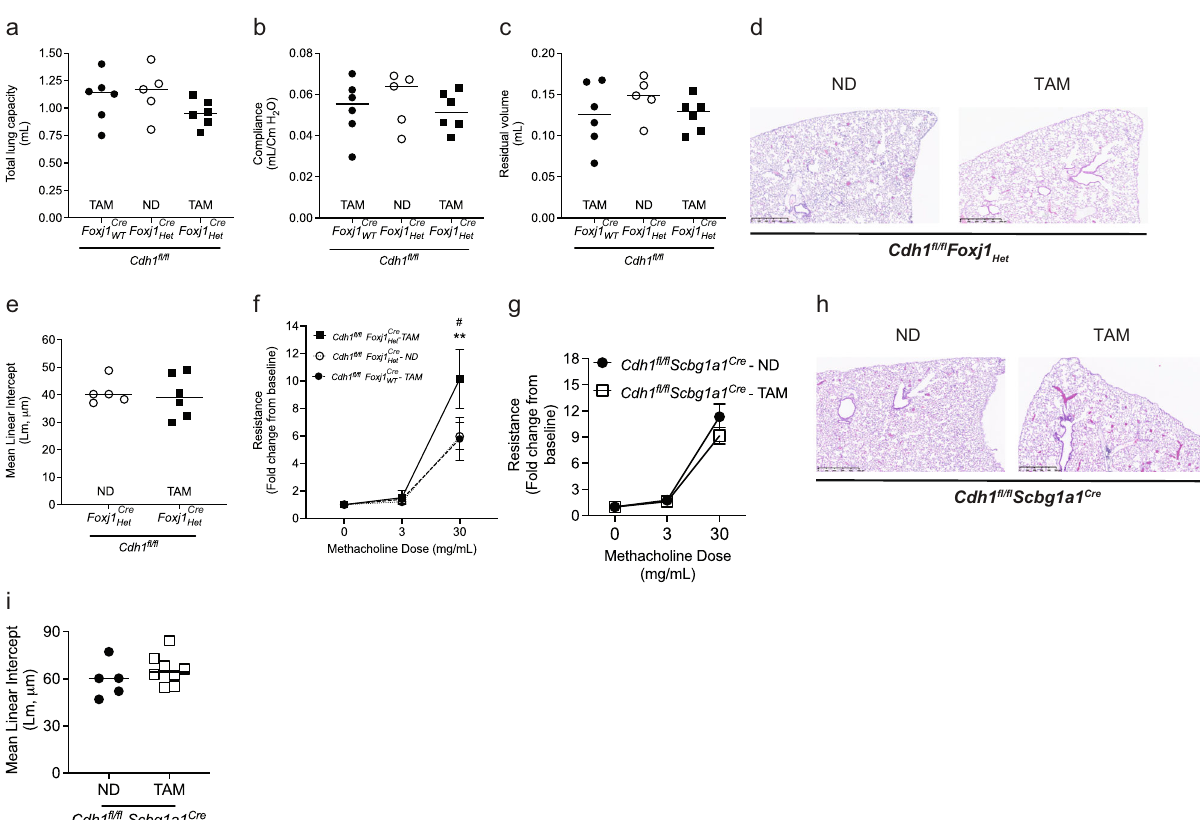
Fig. 5 E-cadherin knockdown in the ciliated cells, but not club cells, contributes to increased airway hyperresponsiveness. To knock down E-cadherin in the ciliated cells of mice lungs, Cdh1 fl / fl - Foxj1 Cre Het mice were fed tamoxifen (TAM) for 30 days. These were compared to Cdh1 fl / fl - Foxj1 Cre Het mice receiving a normal chow diet (ND) and Cdh1 fl / fl - Foxj1 Cre WT receiving TAM control mice. No change in a total lung capacity, b compliance, and c residual volume was observed in the ciliated cells with E-cadherin knockdown of mice lungs. Also, no changes were observed in d H & E staining (representative image at 5X with a scale bar of 500 µ m), and e quanti fi ed mean linear intercepts (Lm) after E-cadherin knockdown in ciliated cells. f Increased airway hyperreactivity (AHR) in ciliated cells with E-cadherin knockdown. Data is expressed as median bars and representative of 5 to 9 mice. To knock down E-cadherin in the club cells of mice lungs, Cdh1 fl / fl - Scbg1a1 Cre mice were fed a TAM for 30 days. These were compared to Cdh1 fl / fl - Scbg1a1 Cre mice receiving an ND. No difference in g airway reactivity, and histology as observed in h H & E staining (representative image), and i MLI among Cdh1 fl / fl - Scbg1a1 Cre receiving a TAM and an ND. Data is expressed as median bars and generated from 5 to 9 mice. Kruskal-Wallis test followed by Dunn ’ s multiple comparison test was performed for total lung capacity, compliance, residual volume, and AHR in E-cadherin knock down in ciliated cells. Mann-Whitney test was performed for airway reactivity in E-cadherin knockdown in club cells and MLI values. P < 0.05 were considered statistically signi fi